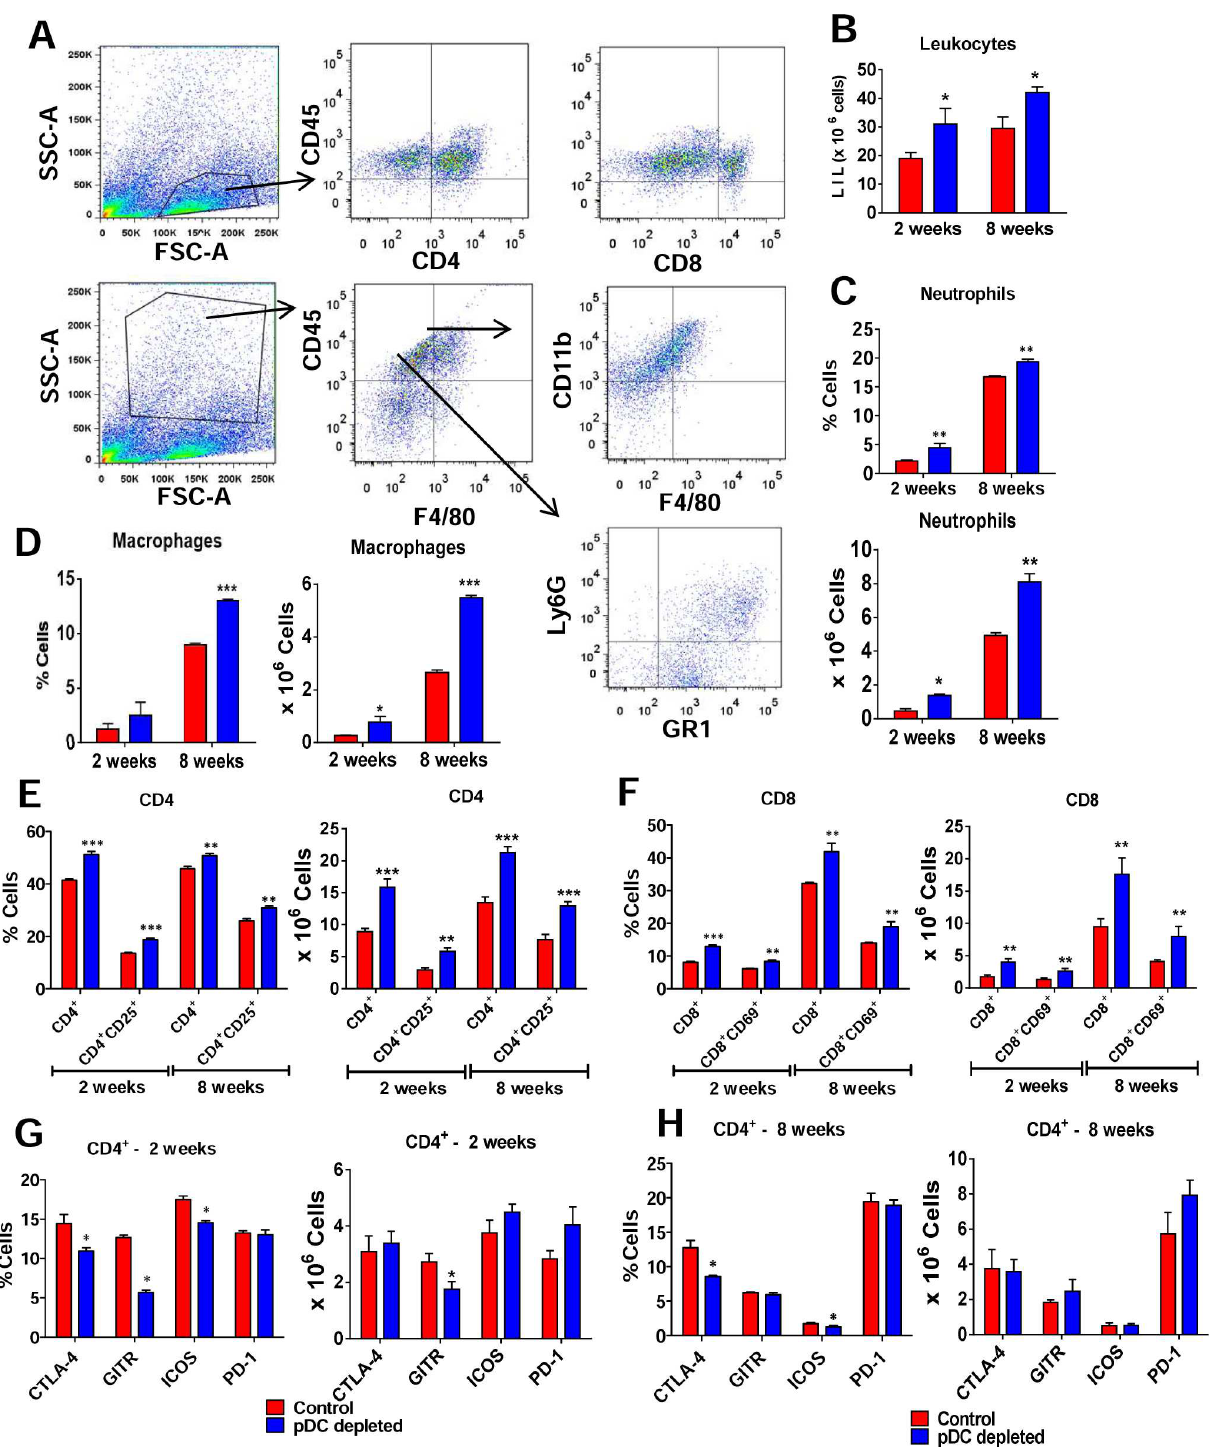
Fig 7. pDC depletion determines increasedpresenceof pulmonary macrophages, neutrophils and activated T lymphocytes. pDC- depletedand control groupswere inoculated i.t. with 1 × 10 6 P . brasiliensis yeasts and cell phenotypes determined at weeks 2 and 8 after infection. Lungsof both mouse groups(n = 4–5) were excised and digested enzymatically. Cell suspensionswere obtainedand stainedas describedin Materials and Methods. The stained cells were analyzedimmediately on a FACSCanto II equipment with gating of lymphocytes or granulocytes, as judgedfrom FSC and SSC scatters. Gated CD4 + and CD8 + cells were also analyzedfor the expressionof